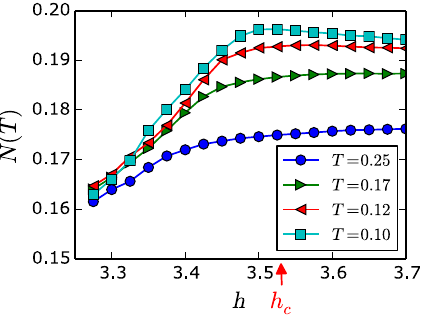
~ N 17. ð T Þ , defined in Eq. (13), as a function of h for system size L ¼ 20 at different temperatures.